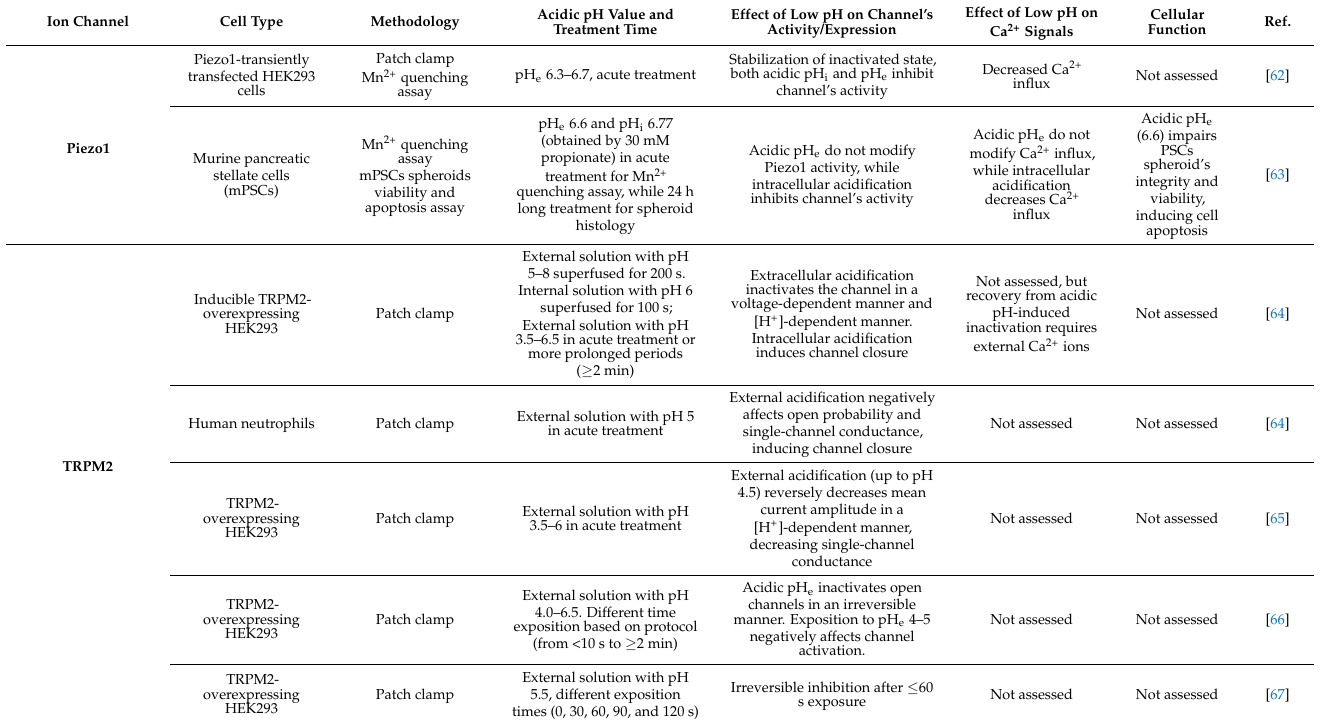
Table 1. Ca 2+ -permeable ion channels regulation by acidic pH e